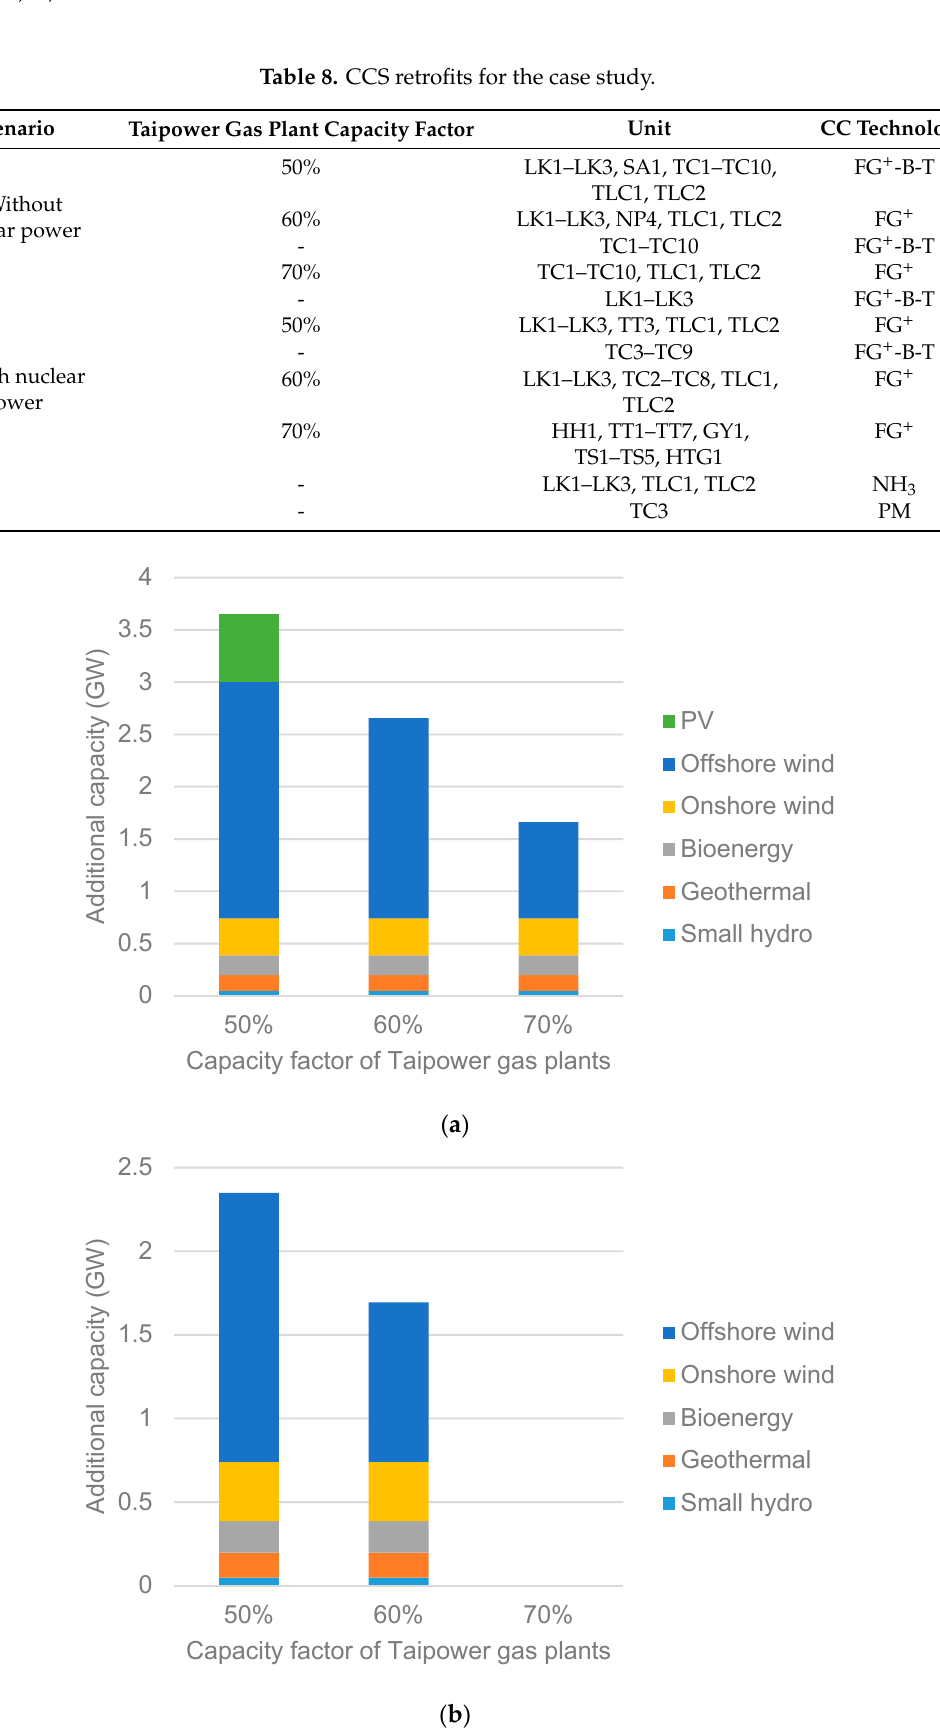
Figure 6. Expansion of renewables for: ( a ) scenario 1; ( b ) scenario 2.